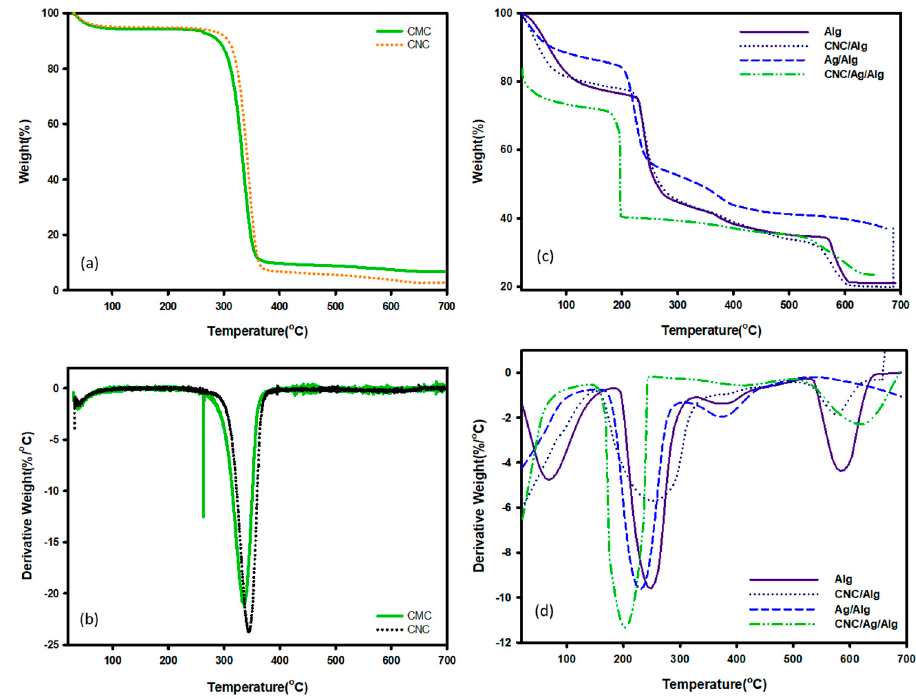
Figure 6. TGA ( a , c ) and DTGA ( b , d ) curve of CMC, CNC, Alg, CNC / Alg, Ag / Alg, and CNC / Ag / Alg samples.